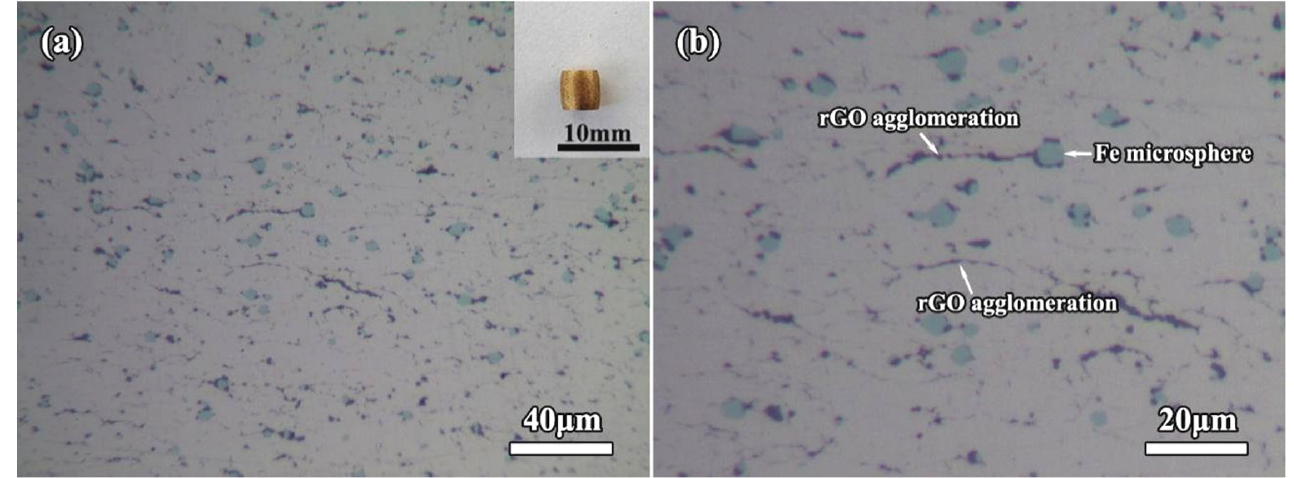
Figure 11. Low- ( a ) and high-magnification ( b ) OM images of the room-temperature deformed 3rGO compact after the compression. The insets show the macrograph of 3rGO compact after compression. The representative tensile stress-strain curves of the as-prepared bulk compacts at room temperature are shown in Figure 12. The comparison of obtained tensile 0.2% yield strength ( σ 0.2 ), ultimate tensile strength (UTS) and elongation values are summarized in Table 2. Under the same sintering process, the tensile σ 0.2 and UTS of 0rGO compact (single Fe microspheres addition) were 109.2 MPa and 251.3 MPa, respectively, which are higher than that of the pure copper. It indicated the remarkable strengthening of Fe